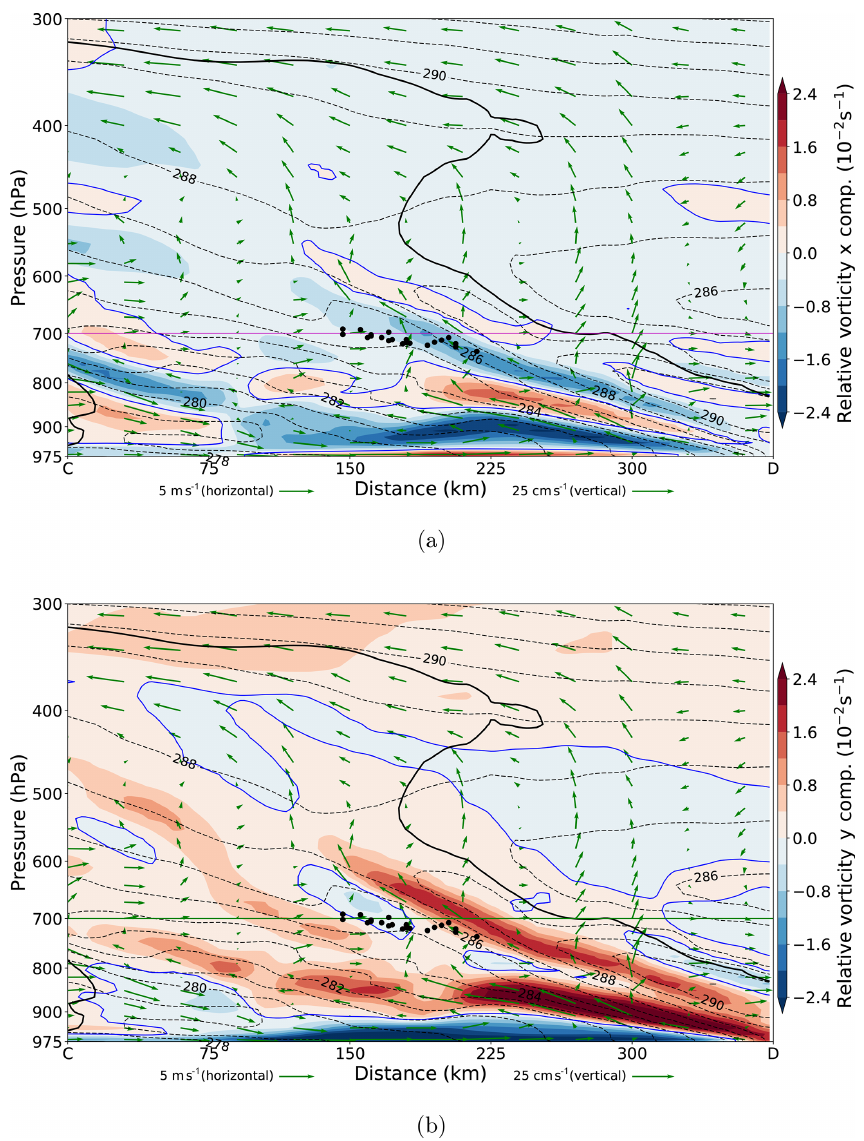
Figure 8. Cross sections on transect CD of Fig. 6a of (a) zonal and (b) meridional components of relative vorticity (shading), θ w (thin black dashed contours; K) and cloudy regions (RH ice = 80%; black bold contours) at 83h from run start. Green wind vectors are constructed using the horizontal wind parallel to the section as horizontal component and vertical velocity multiplied by 24 as vertical component, consistent with the section’s aspect ratio (see scales beneath panels). Black dots show the perpendicular projection on the transect of the trajectories that are less than 25km distant from the relevant transect. The magenta line indicates the pressure of 700hPa, to which Fig. 6a